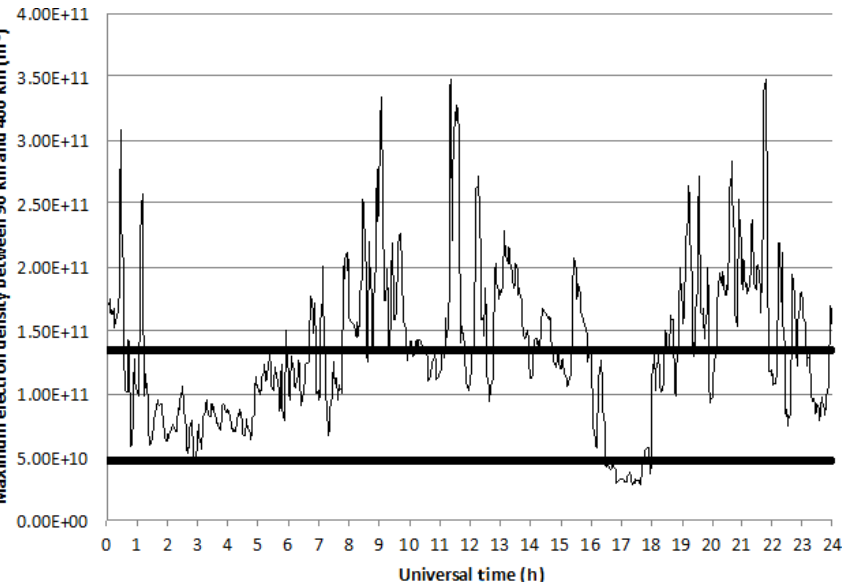
Figure 4. Maximum electron density between 90 and 400km for the ESR 42m observation on the 17 December 2014 at a 1min resolution. A five point running mean was applied to these data. The upper horizontal line is the average value, and the lower horizontal line is 35% of the average. A polar hole can be seen between 16:29 and